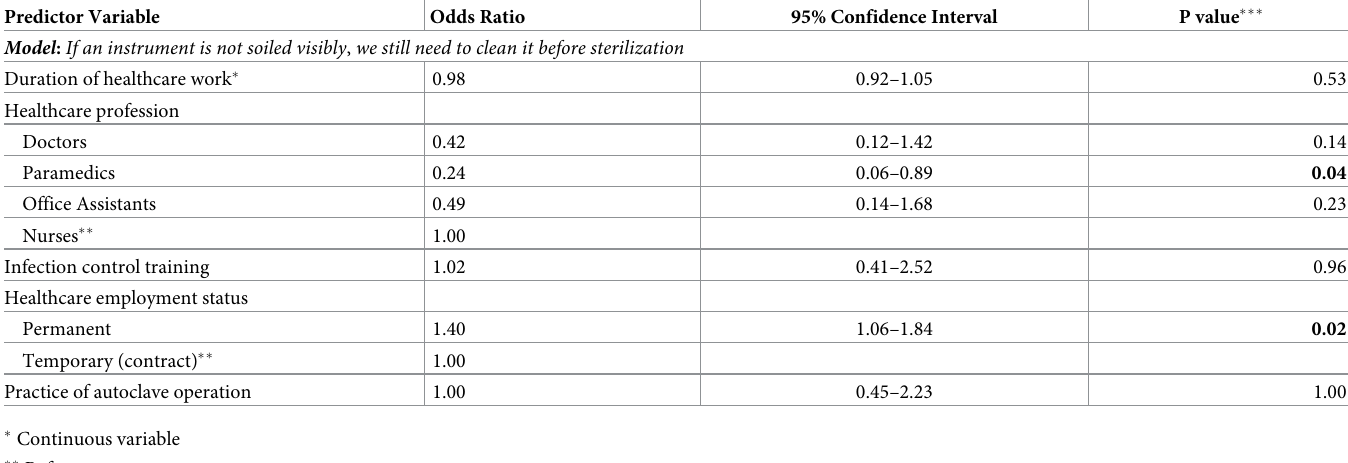
Table 10. Complex samples—ordinal regression models for the attitude of healthcare workers towards cleaning of medical devices. Predictor Variable